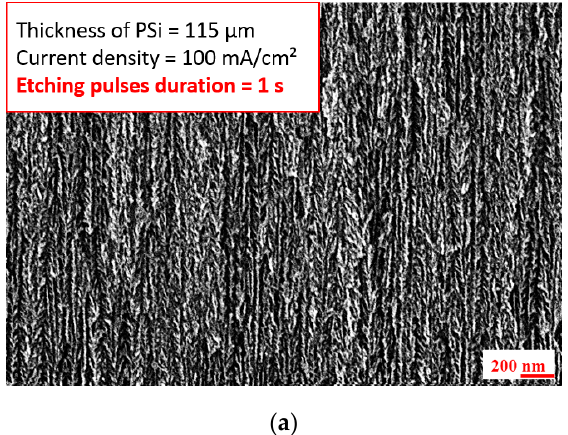
Figure 3. SEM images of PSi in cross-section for different thicknesses: ( a ) PSi-2, ( b ) PSi-3, ( c ) PSi-5, and ( d ) PSi-8 with a current density of 100 mA/cm for 10 s etching pulse duration.